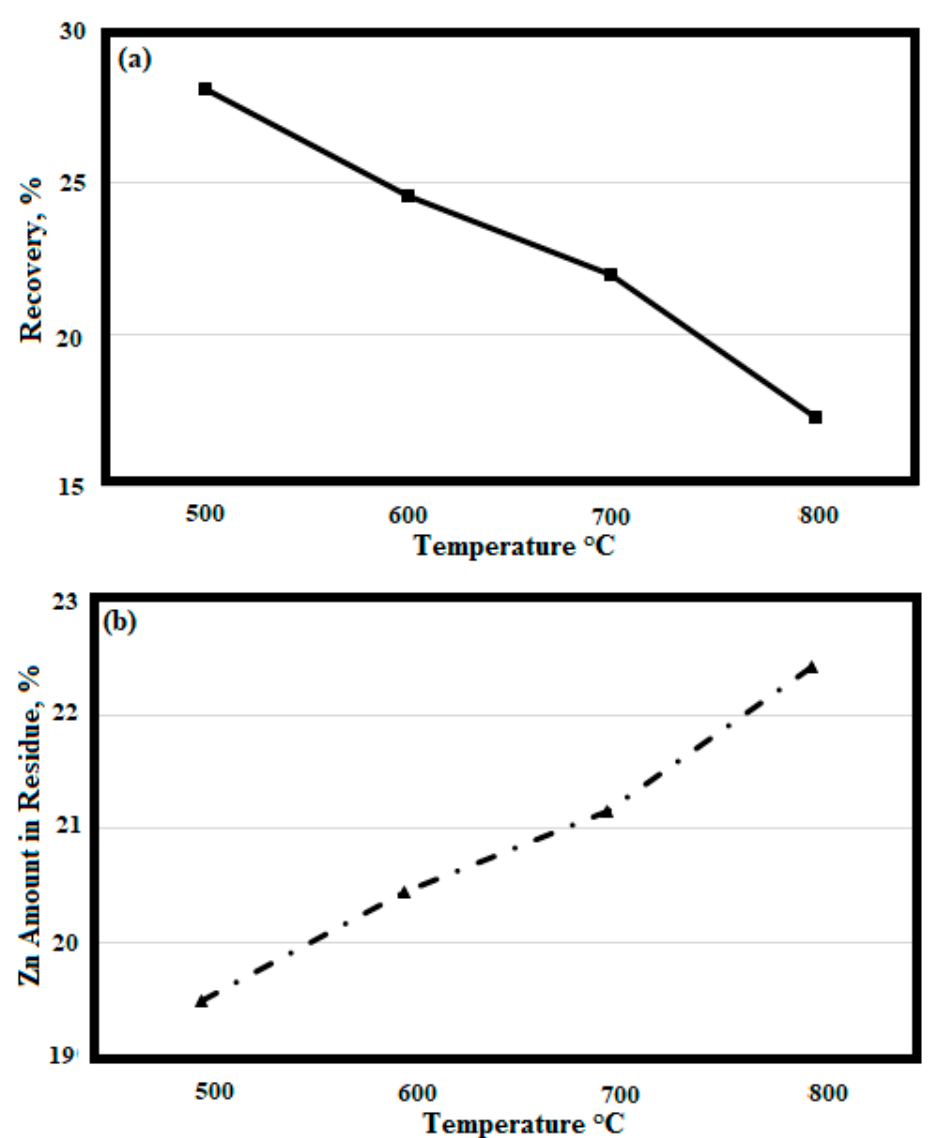
Figure 7. ( a ) Zn recovery, ( b ) Zn amount in residue with coke (1 h, 0.1 mbar vacuum, various temperature).